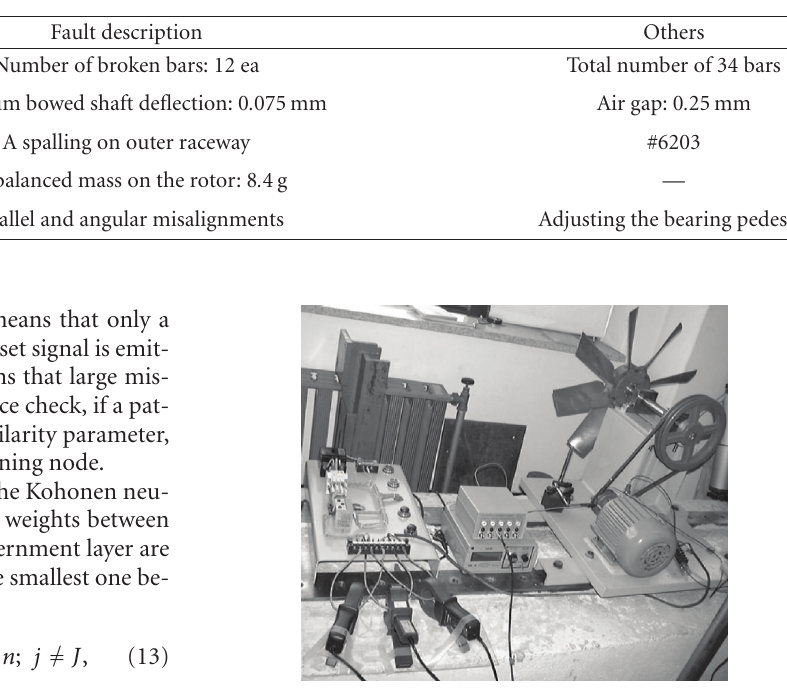
Table 2: Description of faulty induction motors.